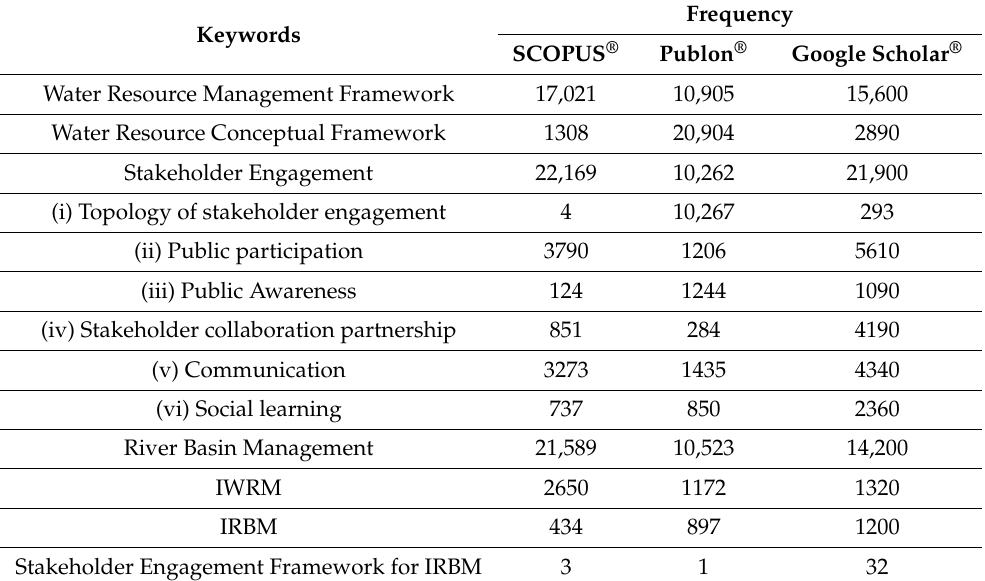
Table 1. Comparison of the number of publications found for each keyword on the three scien- tific databases.